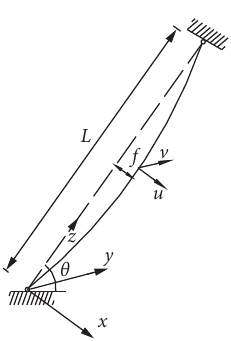
Figure 1: Nonlinear free vibration model of